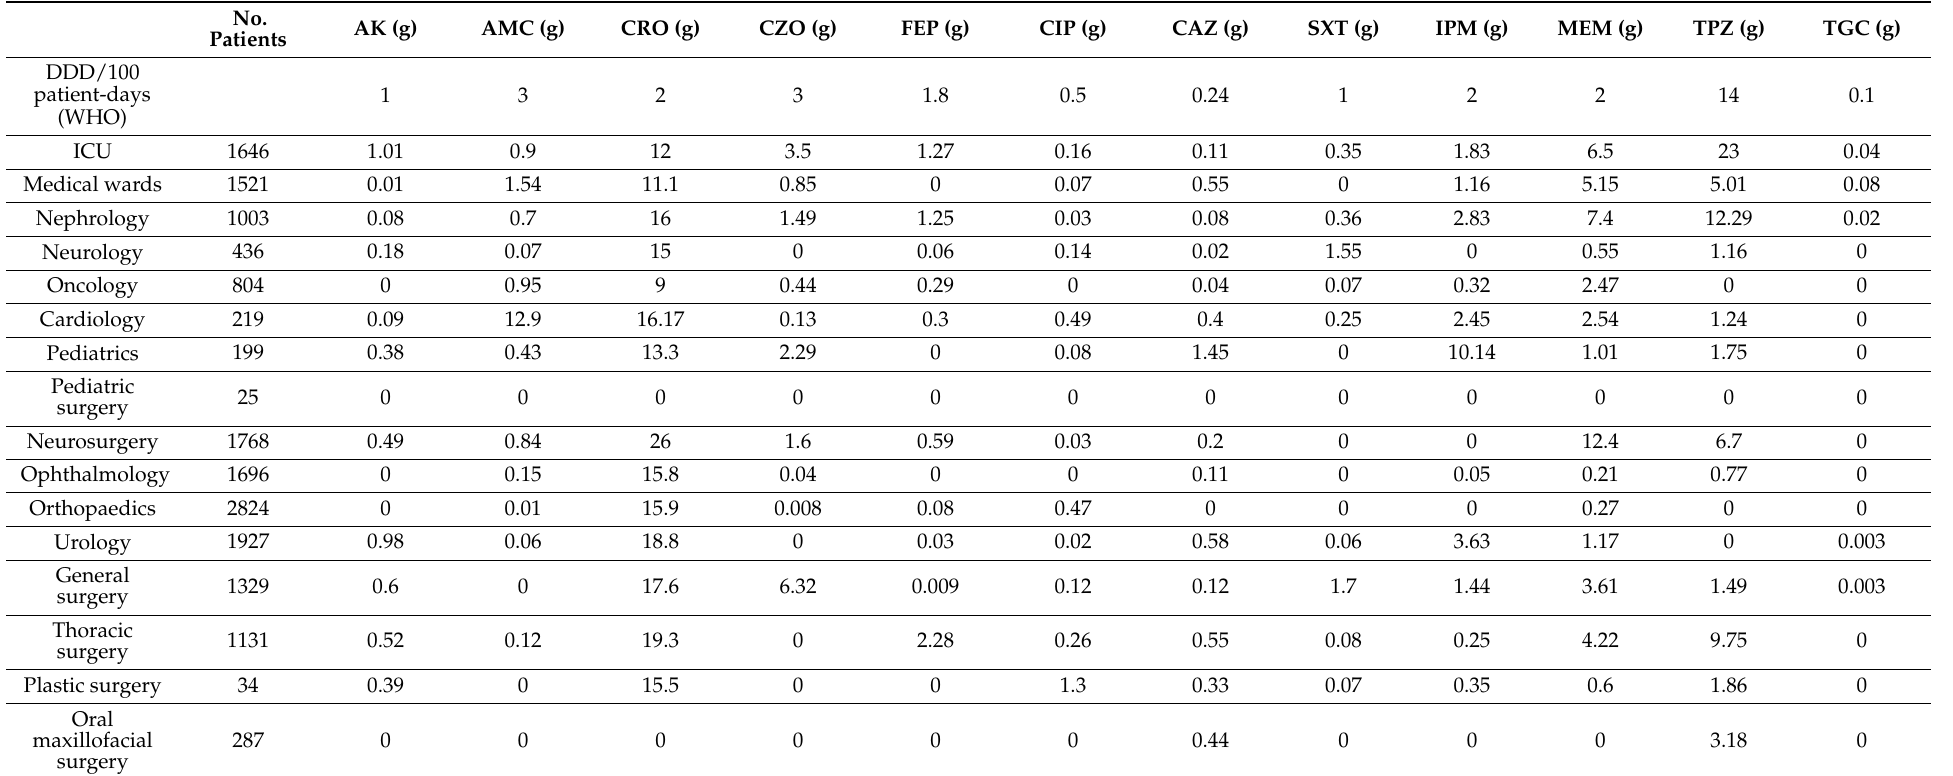
Table 4. Medium annualized antibiotic consumption in the hospital